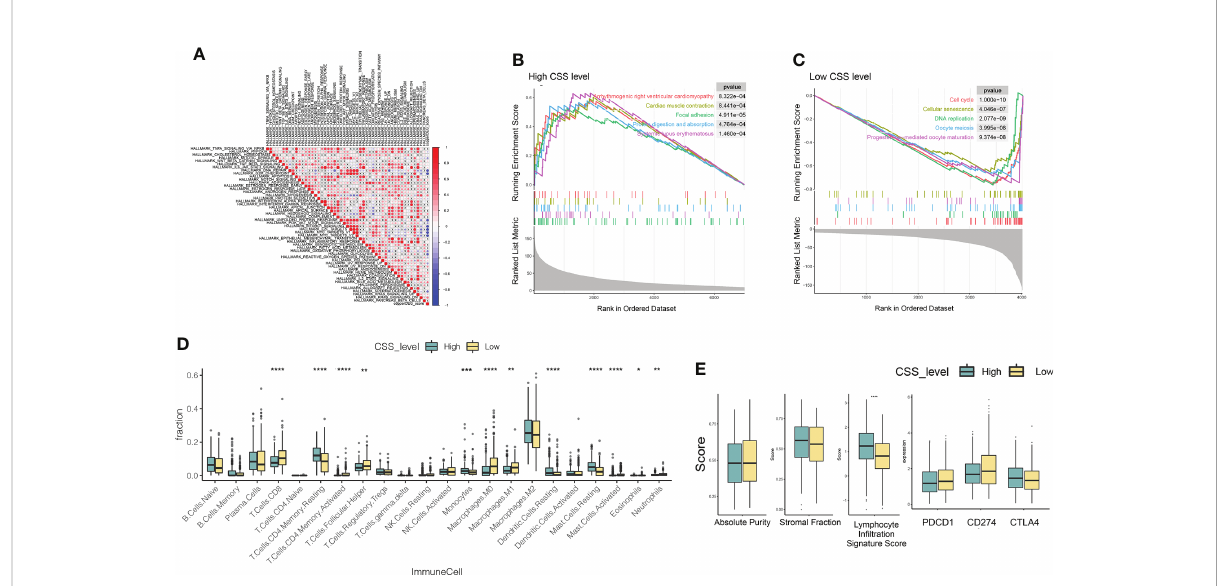
FIGURE 8 Molecular pathways of different CSS subgroups. (A) The Pearson correlation between CSS value and cancer hallmarks. (B, C) Gene sets enriched in CSS-high and CSS-low subgroup ( p < 0.05, FDR < 0.25). (D, E) The distribution of immune cell subsets in fi ltration, absolute purity, stromal fraction, lymphocyte in fi ltration signature score, immune checkpoints between two CSS subgroups. *P<0.05, **P<0.01, ***P<0.001, ****P<0.0001. CSS, cuproptosis scoring